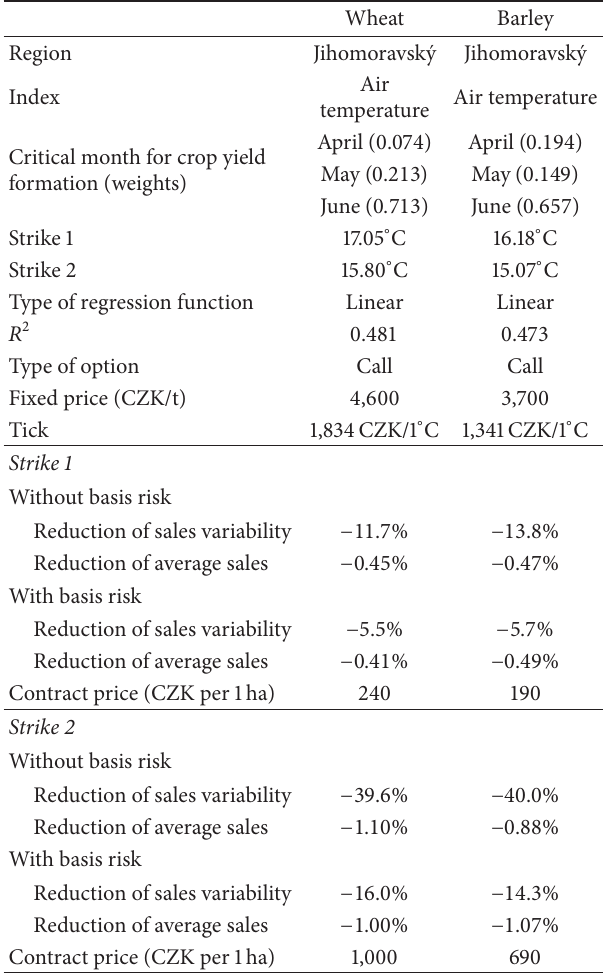
(barley). The logistic distribution of underlying index 𝑇3 is therefore put in parametric bootstrapping. Weather derivative valuation requires estimation of strike, that is, the level of index when the contract starts to pay. Figures 1 and 2 show the risk layering for wheat and barley with farmers’ participation of